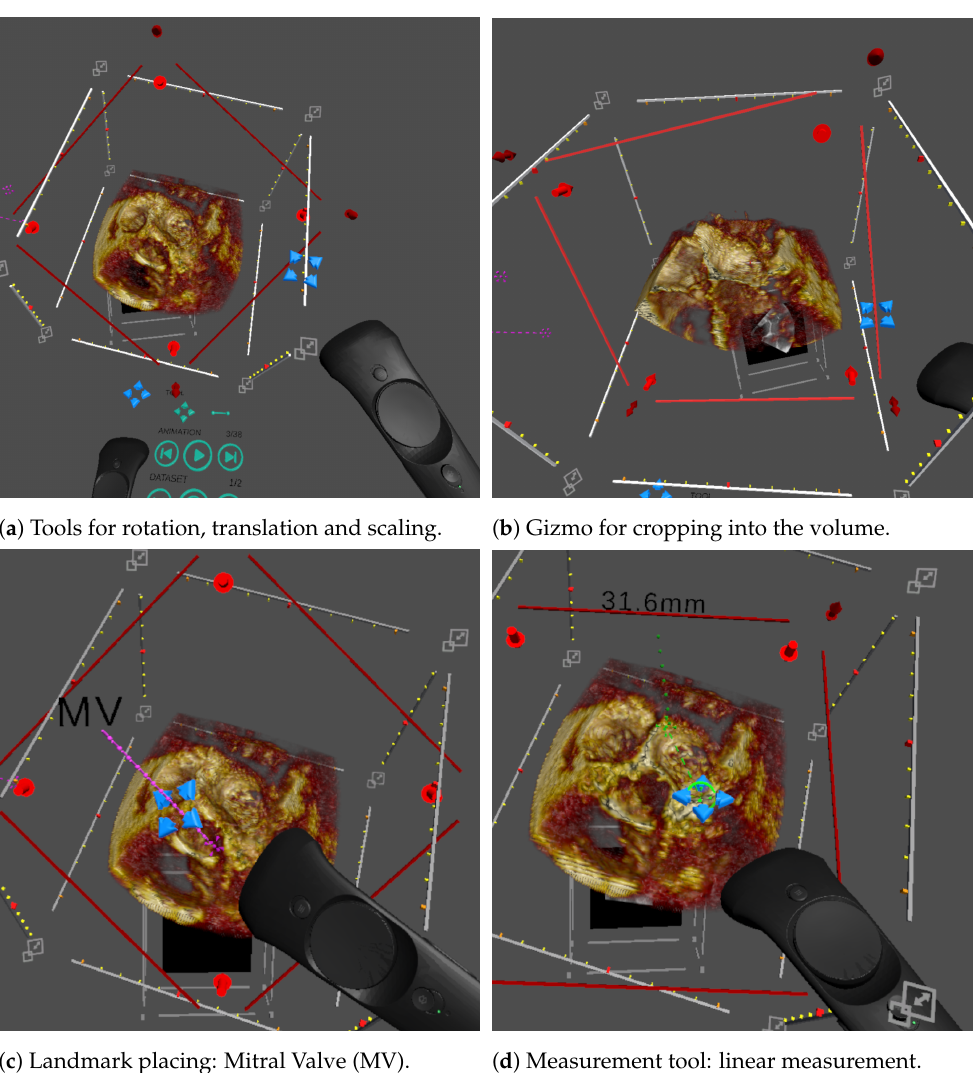
Figure 2. Illustration of the different interactions featured in our VR system, controlled using the blue cross-hair widget attached to the controllers. ( a ) Rotations and translations are highlighted using the volume bounding box. Scaling is applied by pulling the corners of the bounding box. ( b ) Cropping uses a transparent red plane that cuts into the volume. ( c ) Landmarks include a pin point, a label line and a label and can be moved and stretched with the cross-hair tool. ( d ) The linear measurement tool allows the user to draw a green dashed line between two end points and displays the length in